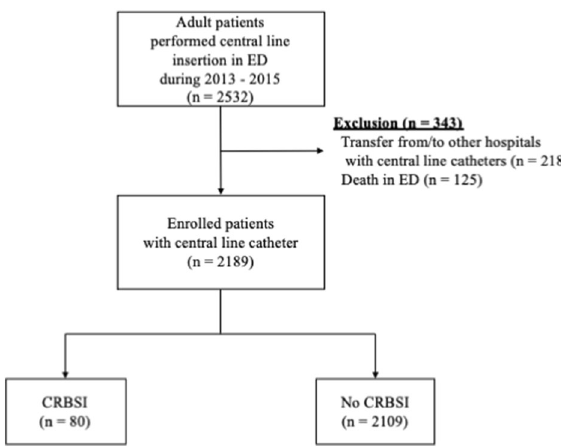
Figure 1. Flowchart of the study sample recruitment process.